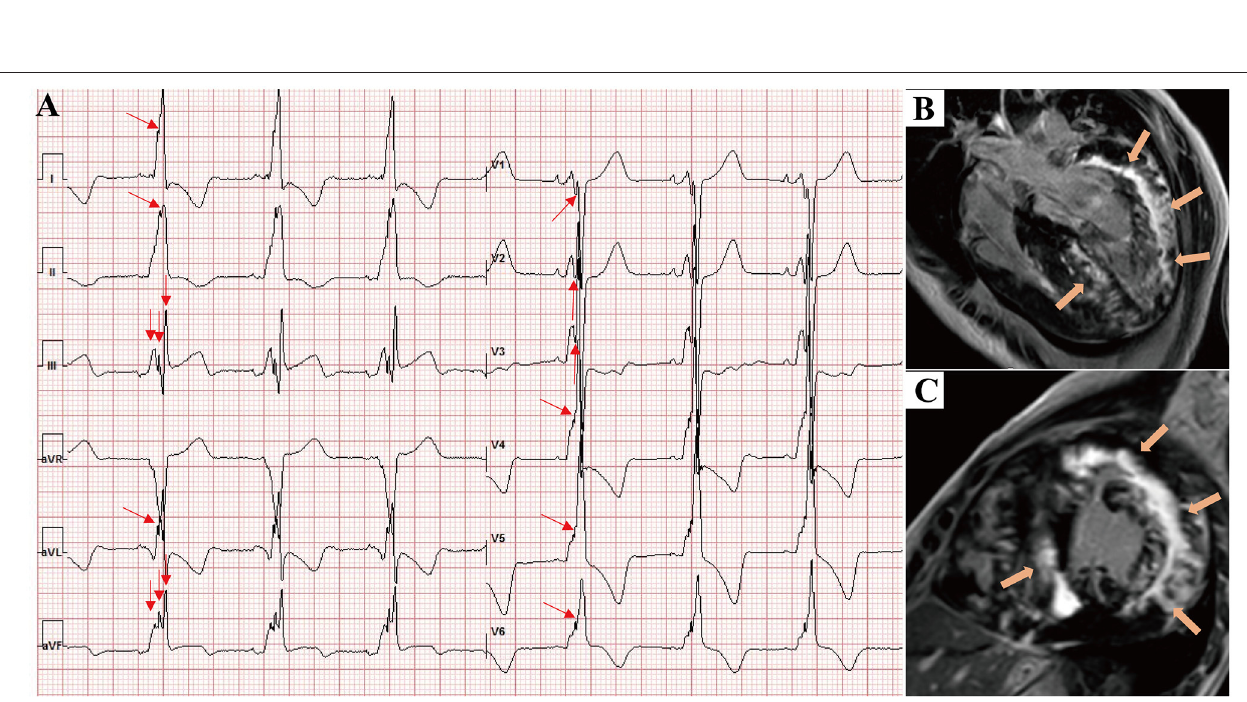
Frontiers in Cardiovascular Medicine |